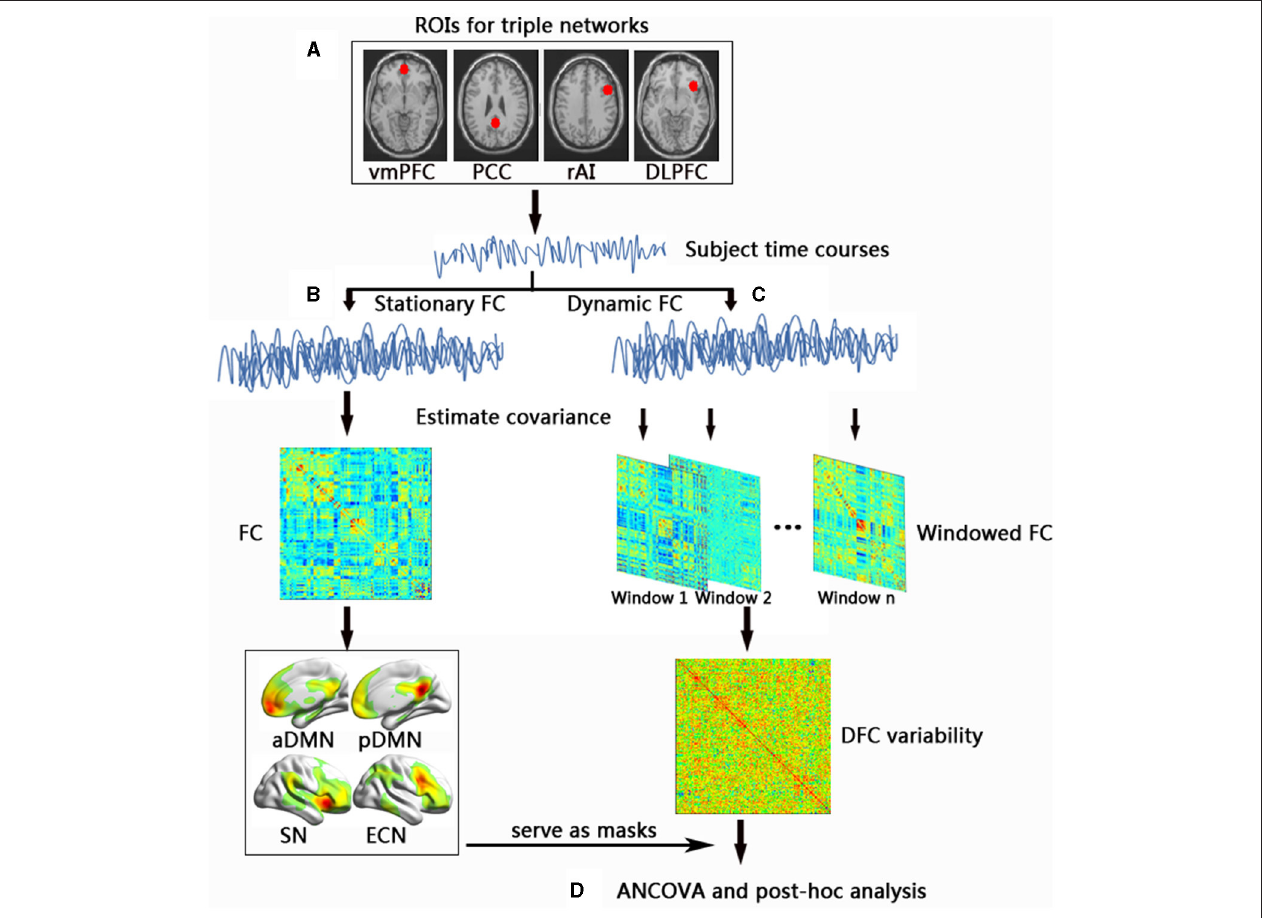
FIGURE 1 | A flow chart for the dynamic functional connectivity analysis in this study. (A) For the RS-fMRI data of all subjects, we first used four ROIs to prepare for the next seed-based functional connectivity analysis. (B) Then, we adopted stationary functional connectivity analysis and obtained the template of the triple networks. (C) We applied the sliding window approach to analyze the dynamic functional connectivity of the obtained 96 windows. Afterward, we calculated dynamic functional connectivity variability across the windows. (D) Last, we performed the statistical analysis. ROI, regions of interests; vmPFC, ventromedial prefrontal cortex; PCC, posterior cingulated cortex; rAI, right anterior insula; DLPFC, dorsolateral prefrontal cortex; FC, functional connectivity; DFC, dynamic functional connectivity; aDMN, anterior default mode network; pDMN, posterior default mode network; SN, salience network; ECN, executive control network. ANCOVA, analysis of